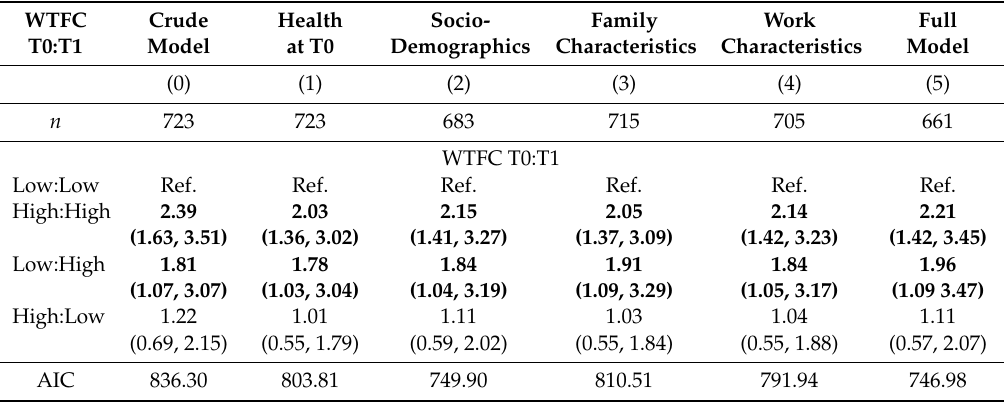
Table 3. Results from the logistic regression (odds ratio and 95% CI) with self-reported general health at T1 as the dependent and WTFC at T0 and T1 as the independent variable for